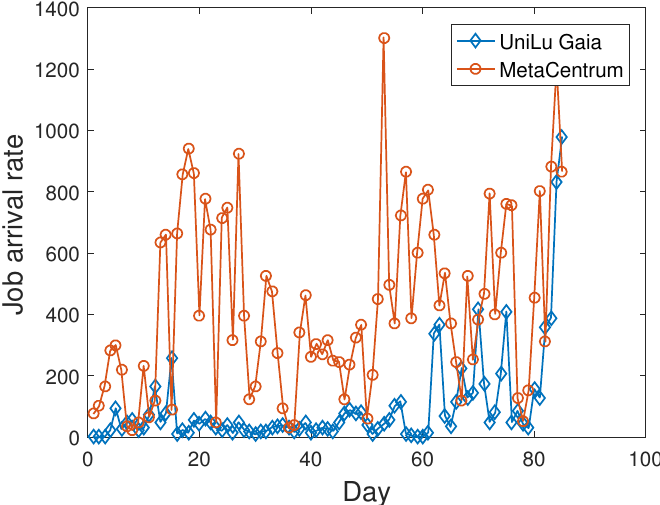
Figure 1. Job arrival rate of Gaia cluster and